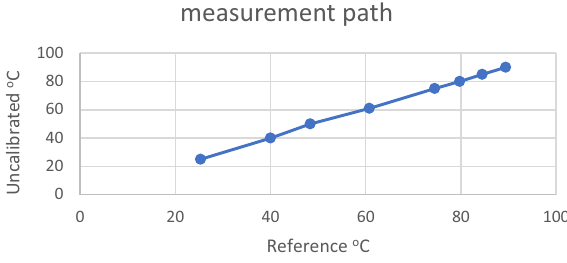
Figure 8. Calibration curve for one temperature measurement path.